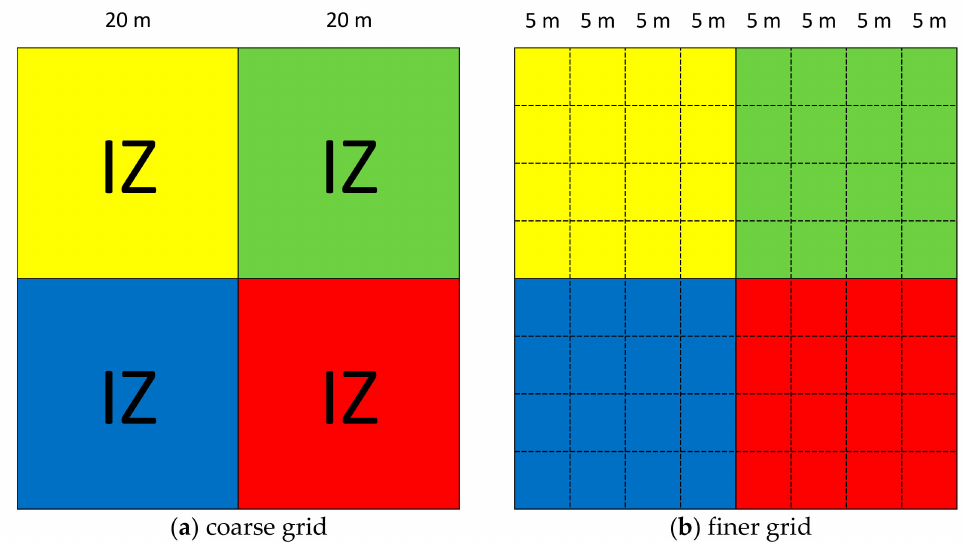
Figure 3. IZ illustration. The block of cells on the left ( a ) represents the coarse grid used by the CA-4D model. Each coarse grid cell acts as an IZ for the finer grid ( b ) used by the D-Flat model.